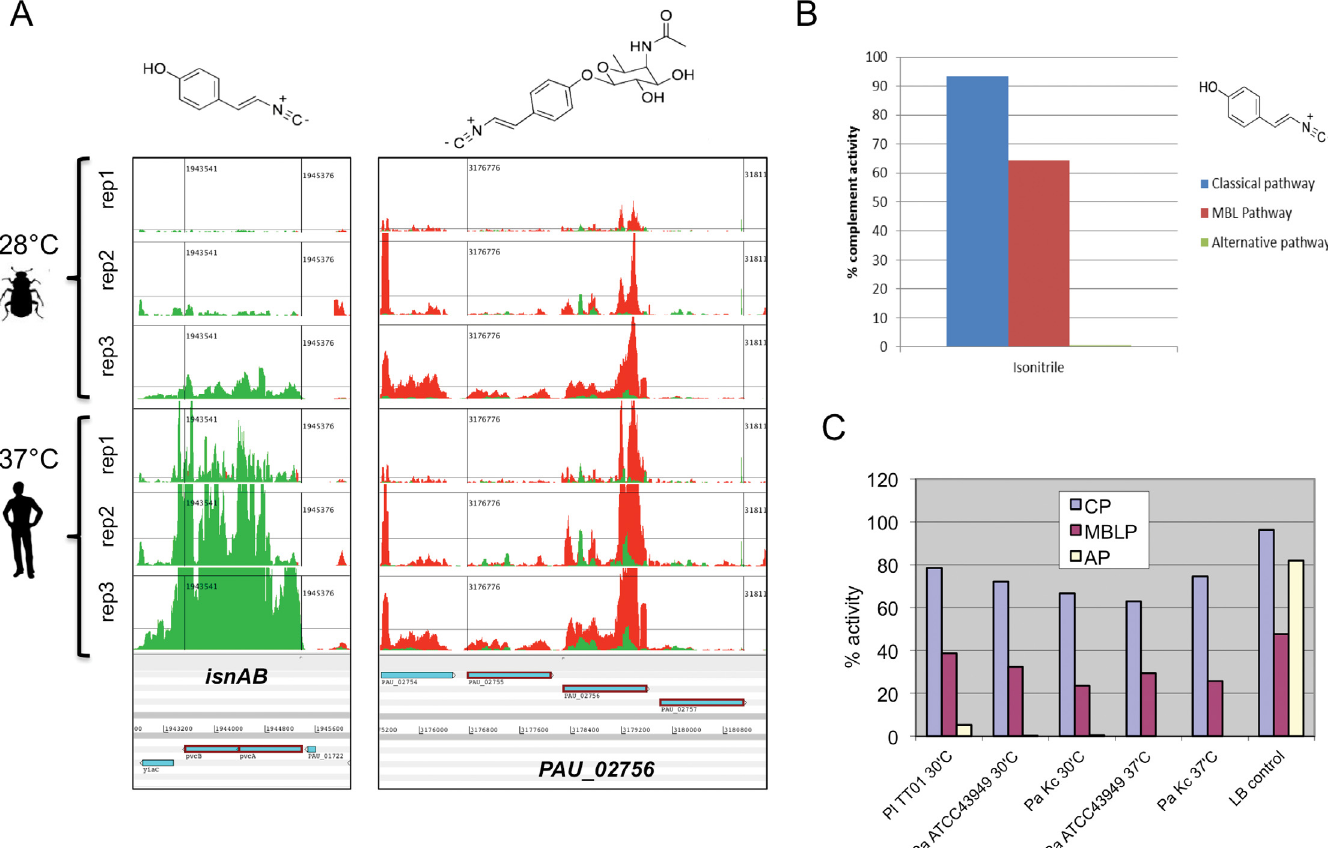
Fig 4. The expression and function of the Photorhabdus natural product rhabduscin. (A) Artemis views of the RNA-seq reads of the three replicates mapped onto the Pa ATCC43949 operons responsible for rhabduscin synthesis. The isnAB genes are responsible for synthesis of the aglycon precursor shown above the left panel. The PAU_02755 – 7 genes encode glycosidase enzymes that add the sugar groups to produce the final rhabduscin molecule. Note PAU_02756 is unique to the P . asymbiotica (replaced by a transposase in Pl TT01 ) and so the final Pa ATCC43949 rhabduscin structure from Pa ATCC43949 may not be the same as that shown from Pl TT01 (above the right panel). (B) The purified aglycon precursor of rhabduscin (shown above the key) is able to completely inhibit the human alternative complement pathway. (C) Cell free supernatants from Pa ATCC43949 (PaATCC43949), Pa Kingscliff (Pa Kc) and Pl TT01 (Pl TT01) can all inhibit the human alternative complement pathway (AP). Note the classical (CP) is only partially inhibited, while LB alone also inhibits the Maltose binding lectin (MBLP) pathway to some